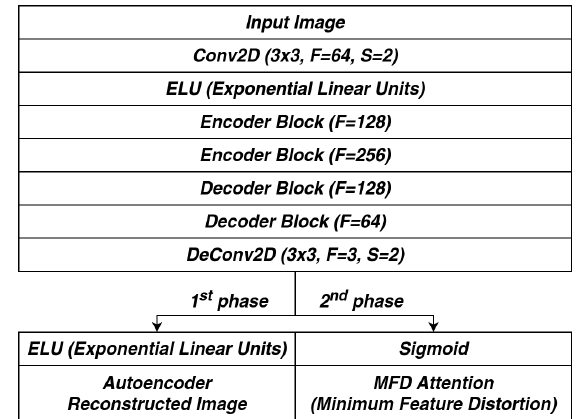
Figure 9. MFD attention model architecture.